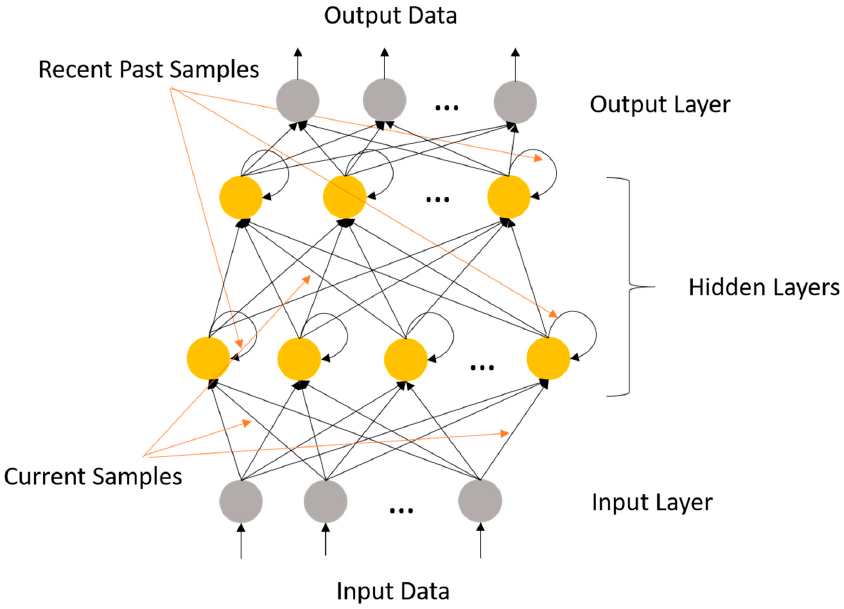
Figure 5. Construction of recurrent neural networks.